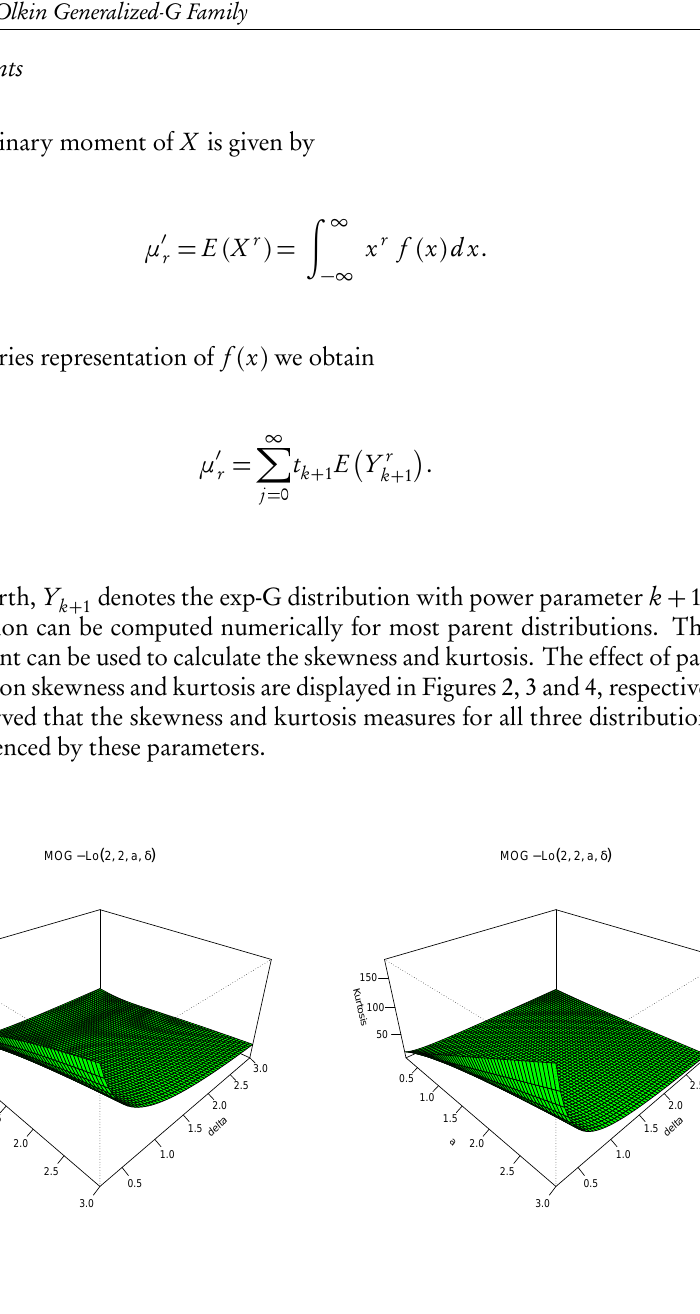
Figure 2 – Skewness(left panel) and kurtosis (right panel) of MOG-Lo